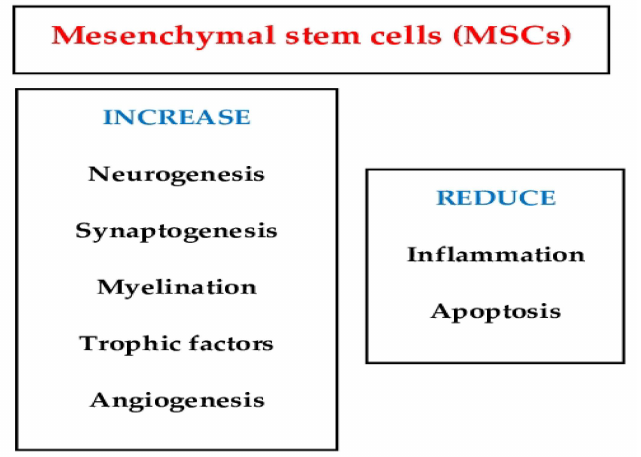
Figure 1. This image shows that the function of mesenchymal stem cells plays significant roles in the repair and regeneration